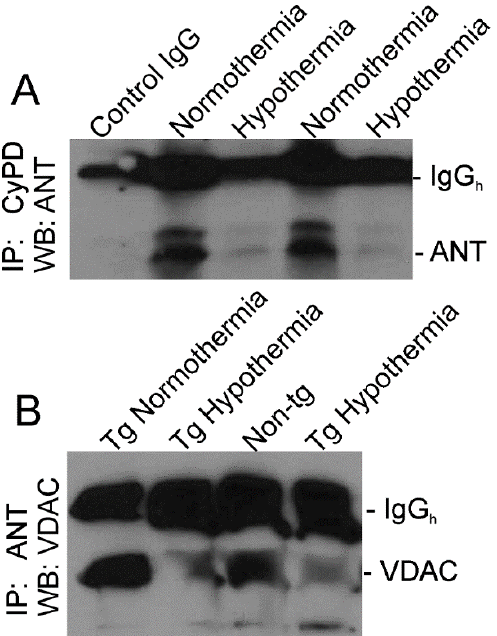
Figure 6. Immunoprecipitation (IP) shows diminished interaction of mPTP related proteins in skeletal muscle of hSOD1-G93A tg mice with cold acclimation at 12 weeks of age. ( A ) IP of CyPD in skeletal muscle mitochondrial-enriched fractions of hSOD1-G93A tg mice with chronic intermittent cooling (hypothermia) and without cooling (normothermia) followed by Western blotting for ANT. IP was done using monoclonal antibody to CyPD (E11Ae12BD4). The negative control was IP with an equal amount of non-immune mouse IgG1 κ . ( B ) IP of ANT in skeletal muscle mitochondrial-enriched fractions of non-tg mice and hSOD1-G93A tg mice with cooling (Tg hypothermia) and without cooling (Tg normothermia) followed by Western blotting for VDAC. IP was done using monoclonal antibody to ANT (5F51BB5AG7).